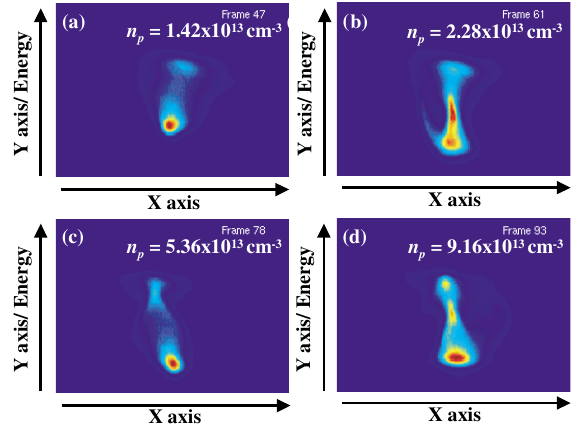
VIDEO 2. Selected frames from the video with explanations given in the text.